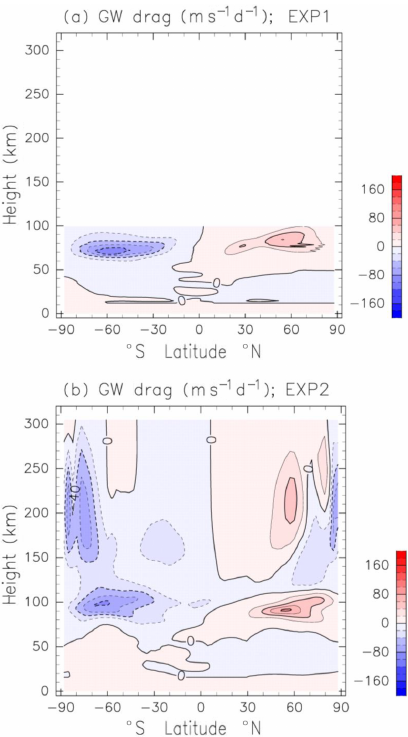
Figure 8. (a) Height–longitude section of the zonal GW drag at 35 ◦ N obtained by EXP2. Data are averaged between 00:00 and 01:00UT in June. Units are meters per second per day. (b) As in (a) except for zonal-wind component. Units are meters per second.